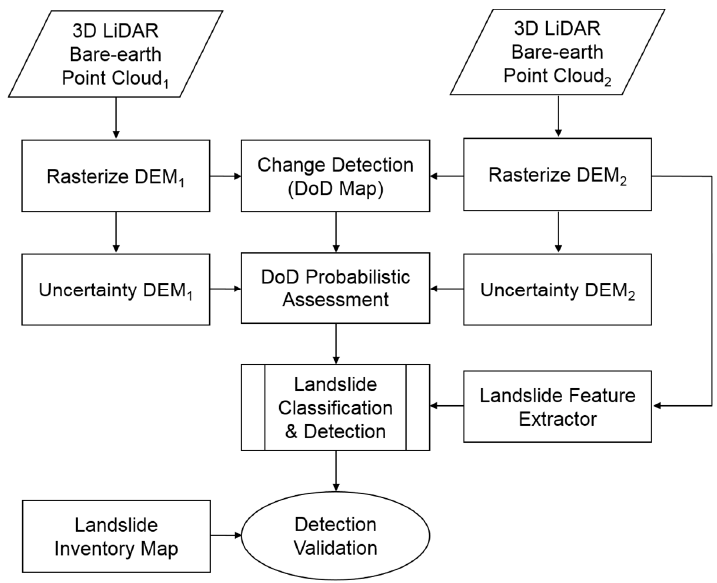
Figure 3. Workflow to detect and map landslide temporal changes.